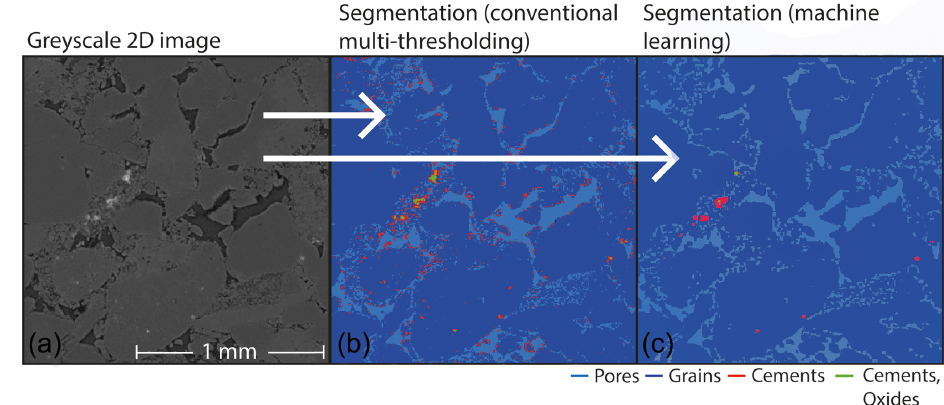
Figure 3. (a) Greyscale 2D µXCT image of a mini plug. (b) Segmented phases using multi thresholding. (c) Segmented phases using the machine learning image classification module of the software ilastik (Version 1.3.3) by Berg et al.